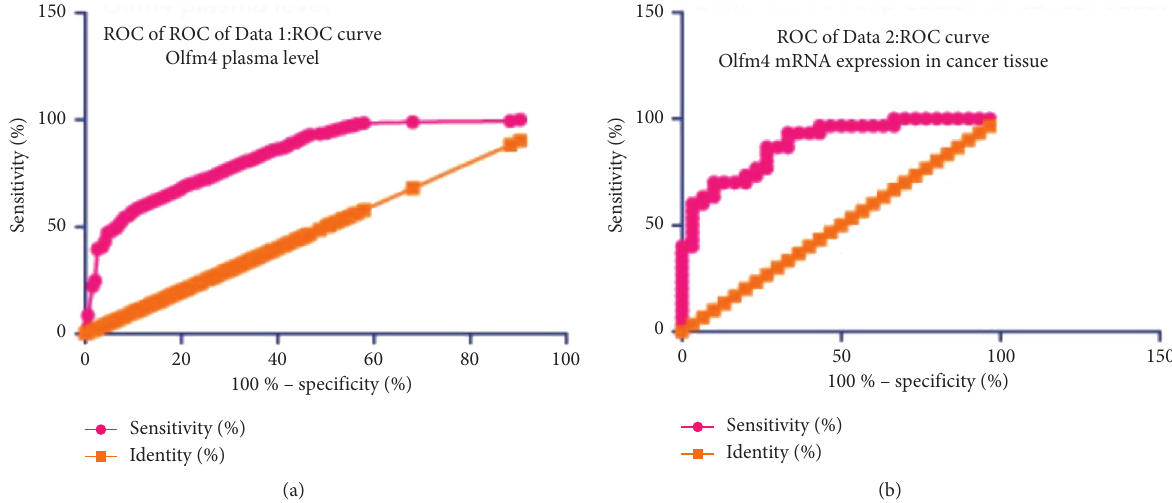
Figure 3: ROC analysis of the performance of OLFM4 expression in identification of HCC. (a) ROC analysis using the blood level of OLFM4 to predict HCC; (b) ROC analysis using the mRNA expression of OLFM4 in liver cancer tissue to predict